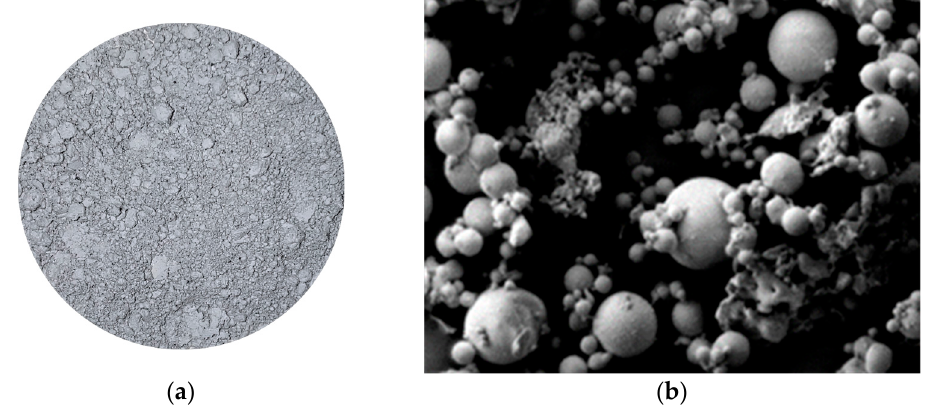
Figure 2. The photo of fly ash: ( a ) Photo of fly ash; ( b ) Micrograph of fly ash.